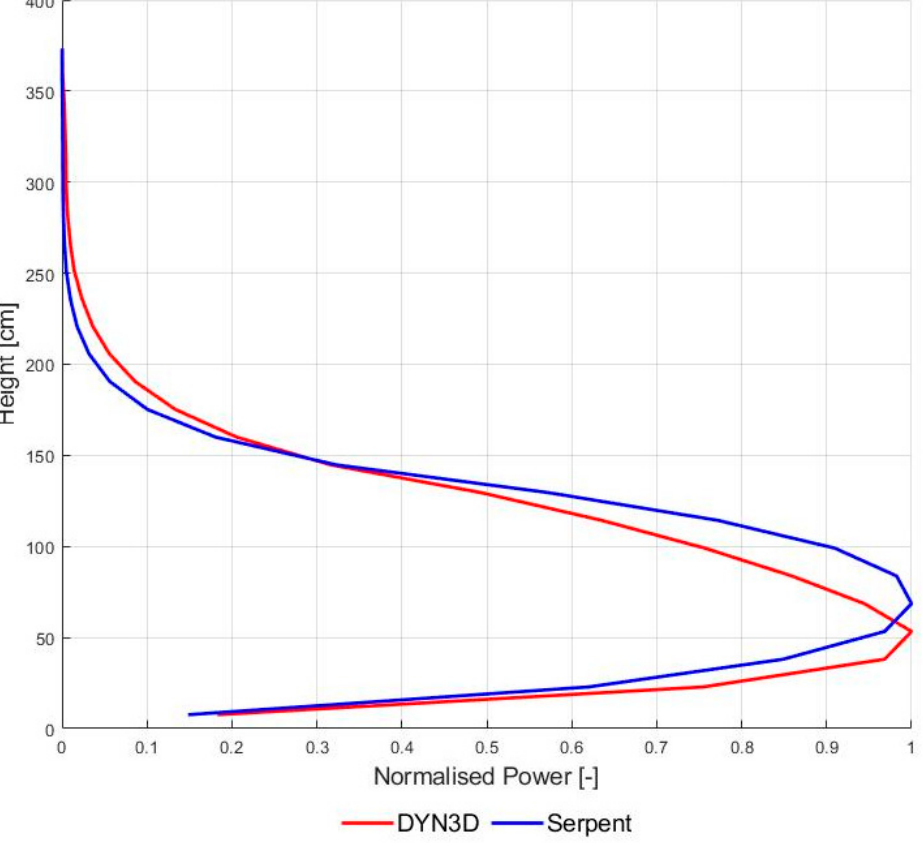
Figure 30. The axial power profile of Serpent/CTF and DYN3D.